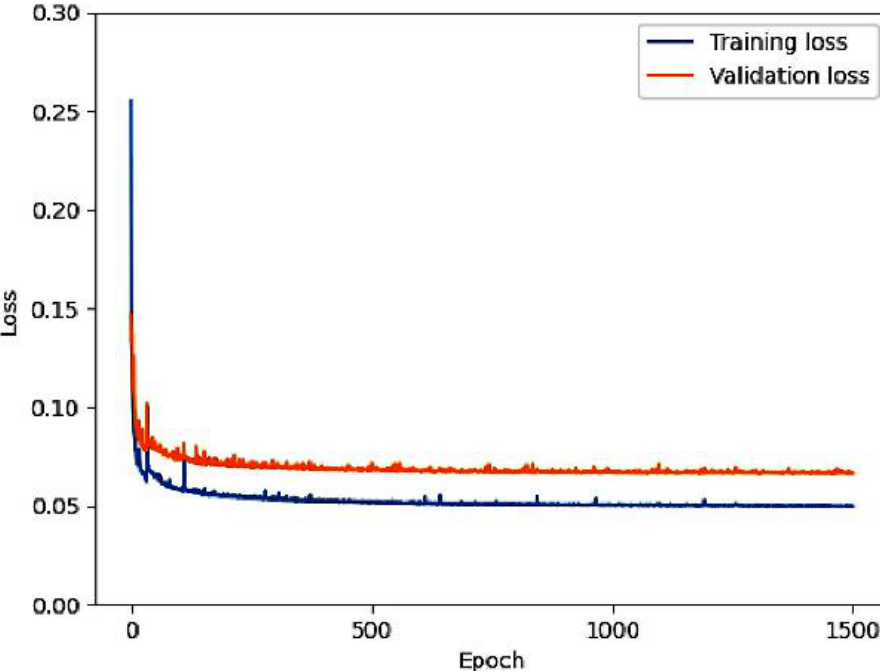
Figure 6. Training and validation losses of the proposed technique.